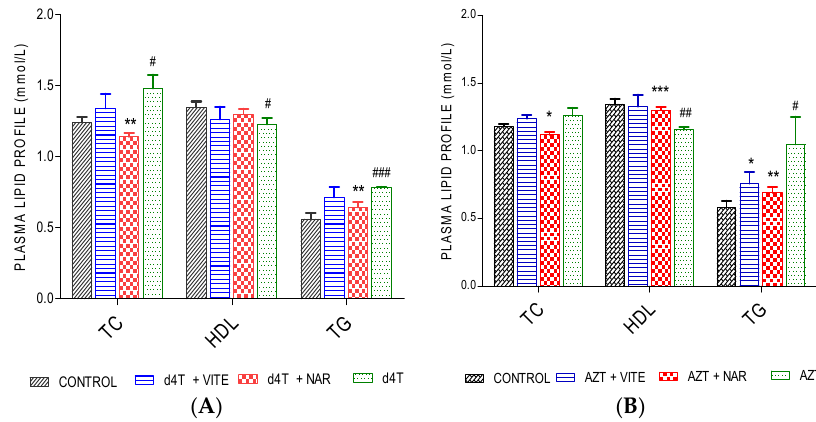
Figure 3. Plasma lipid profile following 56 days of d4T and AZT administration. ( A ) d4T ‐ (** p < 0.01 (compared to d4T) and # p < 0.05; ### p < 0.001 compared to control) and ( B ) AZT ‐ (* p < 0.05; ** p < 0.01; *** p < 0.001 compared to AZT and # p < 0.05 and ## p < 0.01 compared to control) treated animals after 56 days of drug administrations.